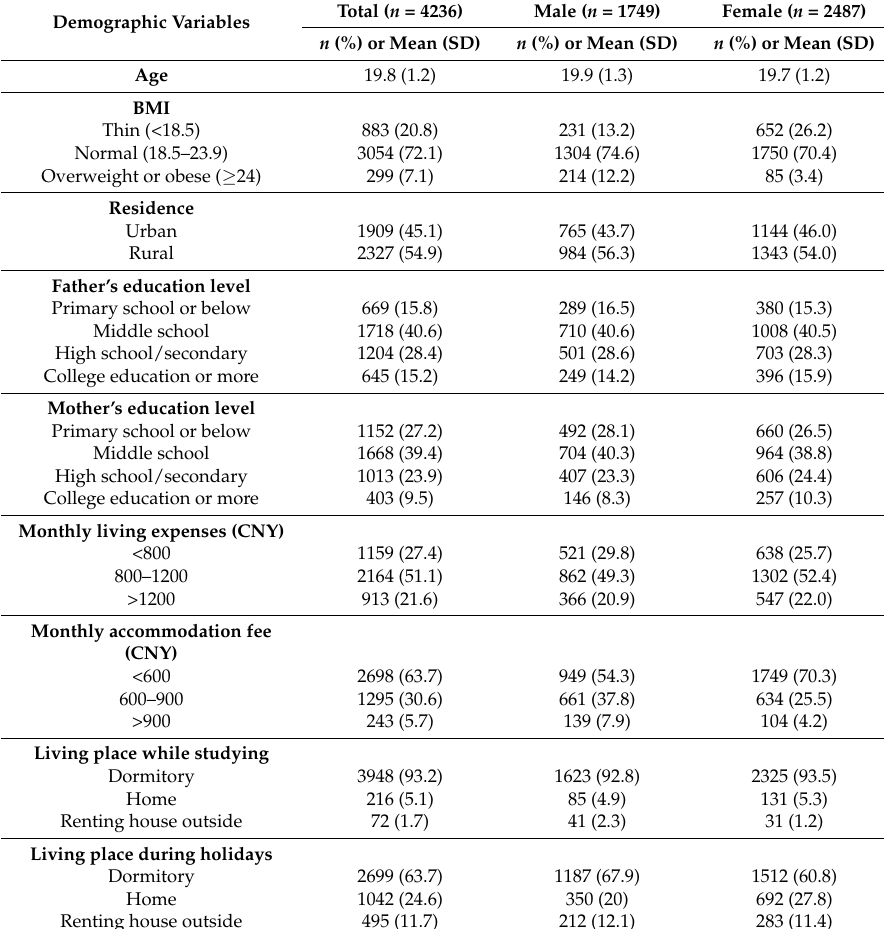
Table 1. Demographic characteristics of the study population by gender ( n = 4236). Demographic